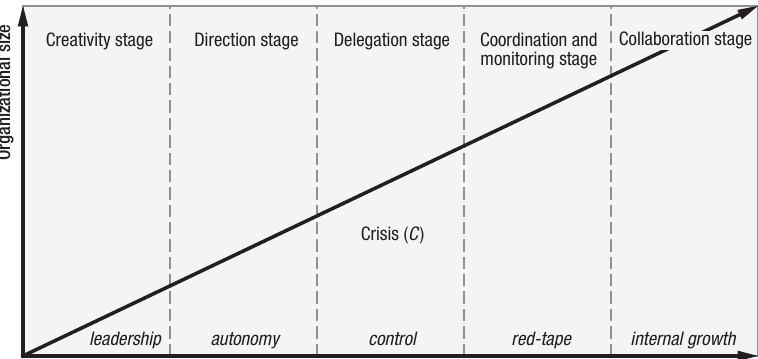
Fig. 3. Greiner‘s conception of company development and crisis stages (according to the Growth Phases